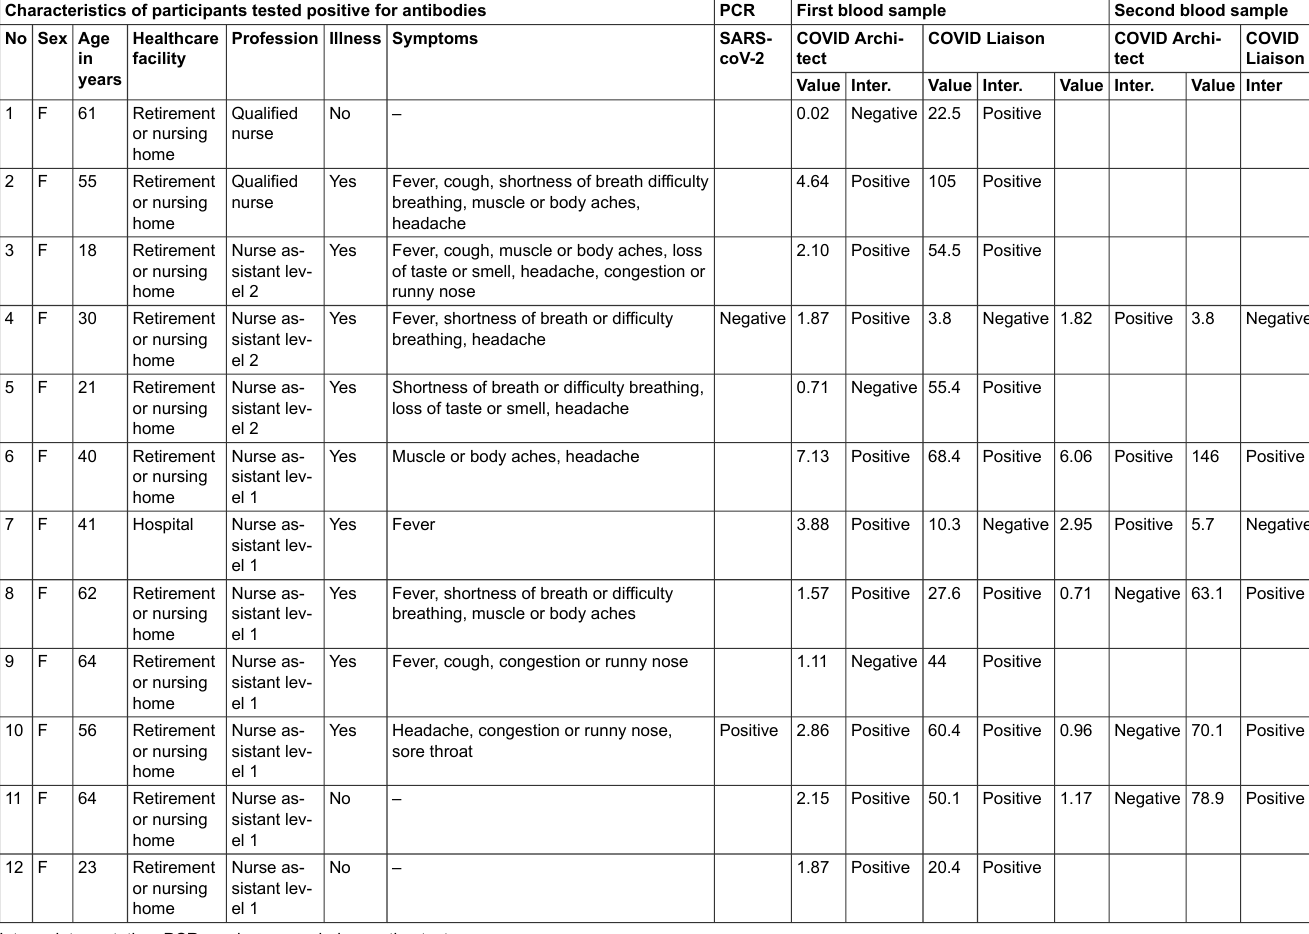
Table 3: Characteristics of the twelve study participants seropositive for SARS-CoV-2. Characteristics of participants tested positive for antibodies PCR First blood sample Second blood sample